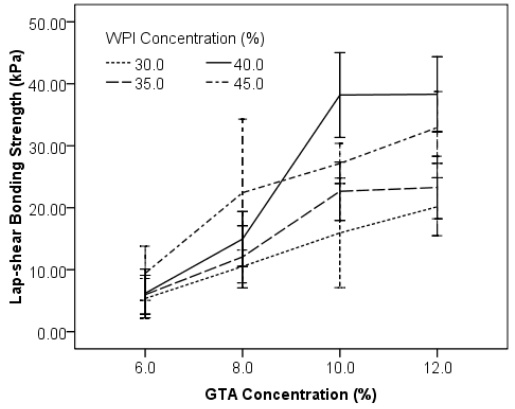
Figure 5. Effects of WPI and GTA concentrations on lap-shear bonding strength.